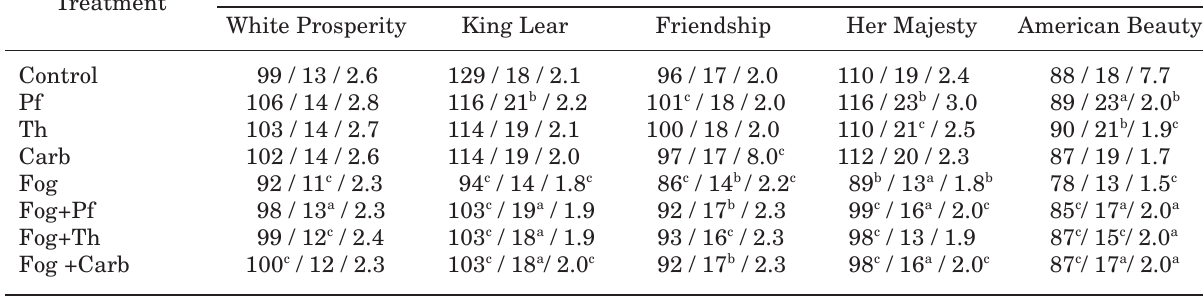
Table 3. Effect of application of Pseudomonas fluorescens (Pf), Trichoderma harzianum (Th) and carbendazim (Carb) on flowering variables of gladiolus cultivars grown in the soil with or without Fusarium oxysporum f. sp. gladioli (Fog).